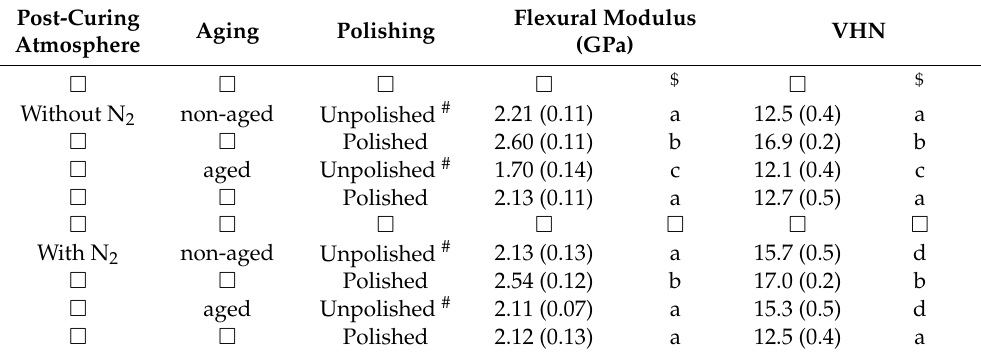
Figure 4. Mean values (standard deviations) of flexural strength. The same superscripted letters indicate groups not statistically significantly different when compared by 1-way ANOVA and post hoc analysis with Tukey multiple comparisons. # : data of unpolished subgroups were quoted from the previous study [19]. Table 2. Mean values and standard deviations of flexural modulus and VHN, and results of 1-way ANOVA statistical